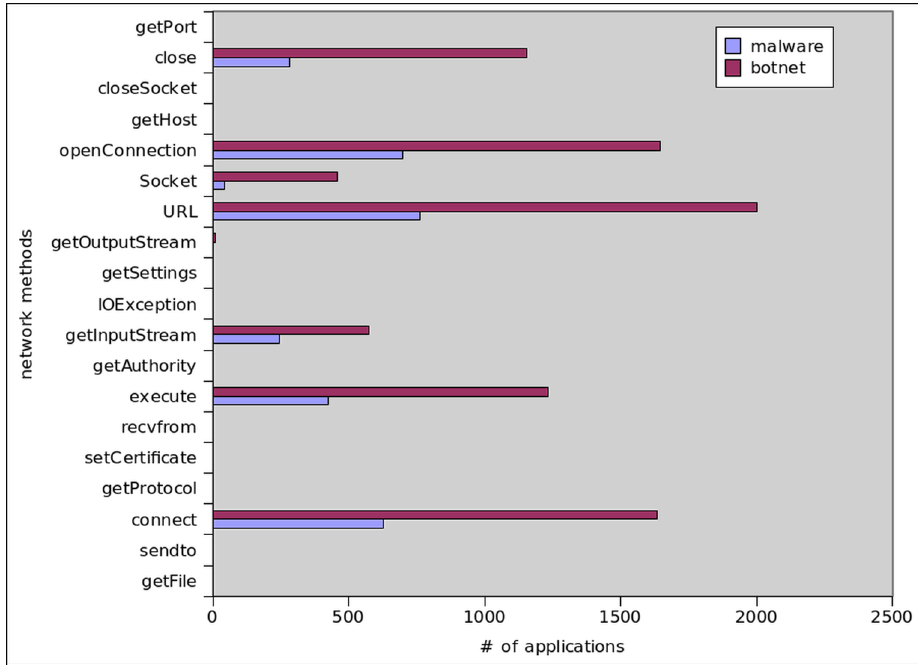
Fig 24. Most Common Network Methods Called by Botnet and Malware